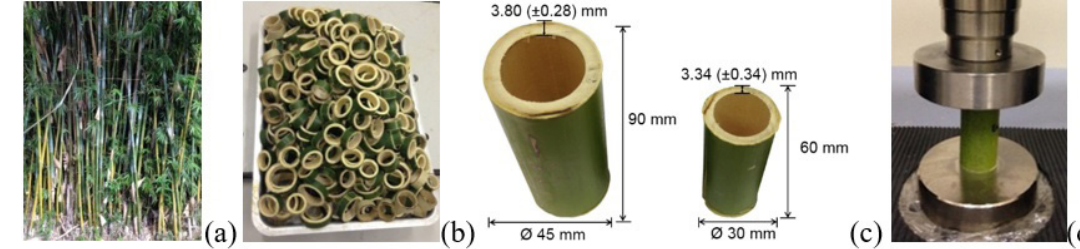
Figure 2. (a) Bamboo culms, (b) bamboo rings, (c) bamboo samples for (d) compression test.